Question: What style of plot is this figure drawn as?
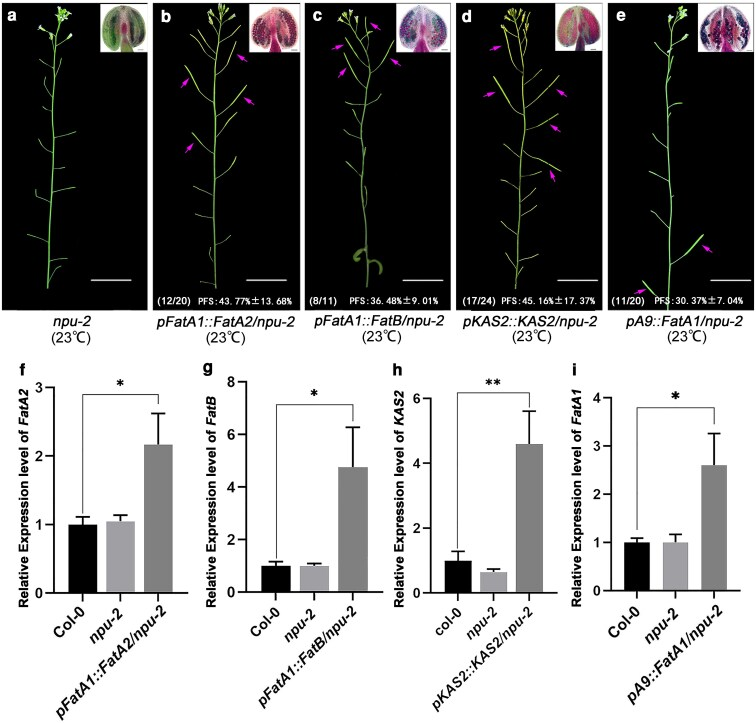
Answer: bar